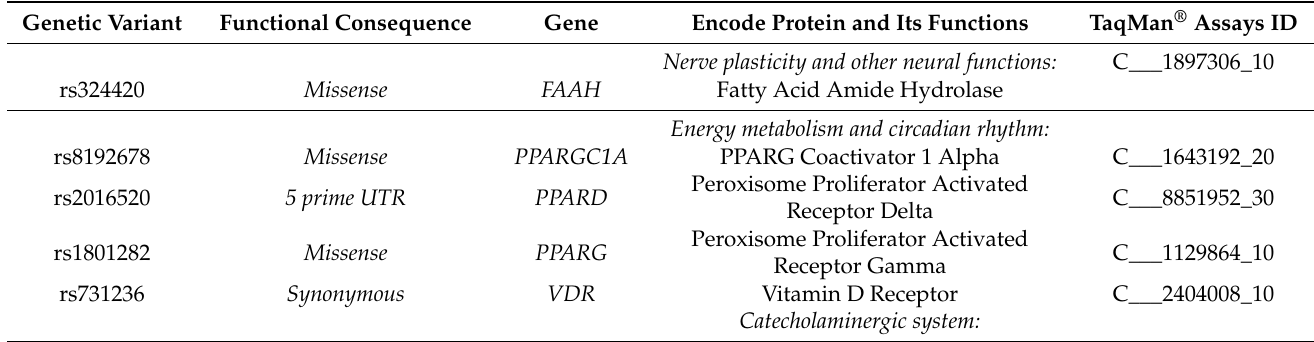
Table 2. Selected polymorphisms’ description and TaqMan ® assays